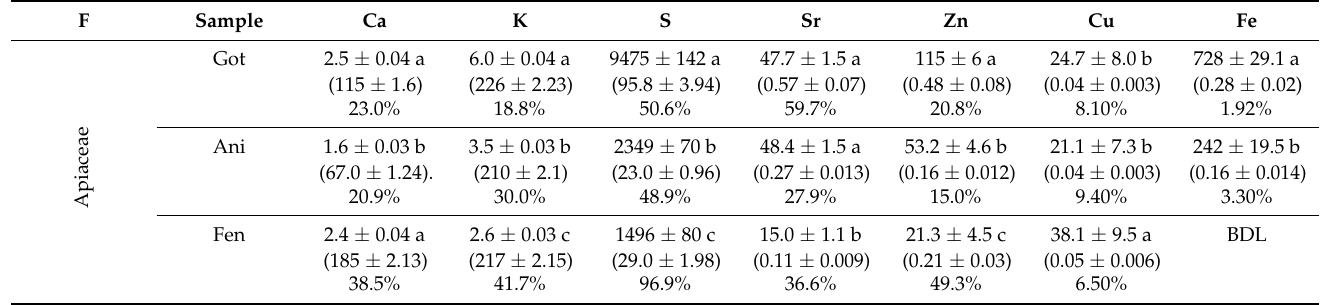
Table 2. Average levels of Ca, K, S, Sr, Zn, Cu, and Fe in the different plant